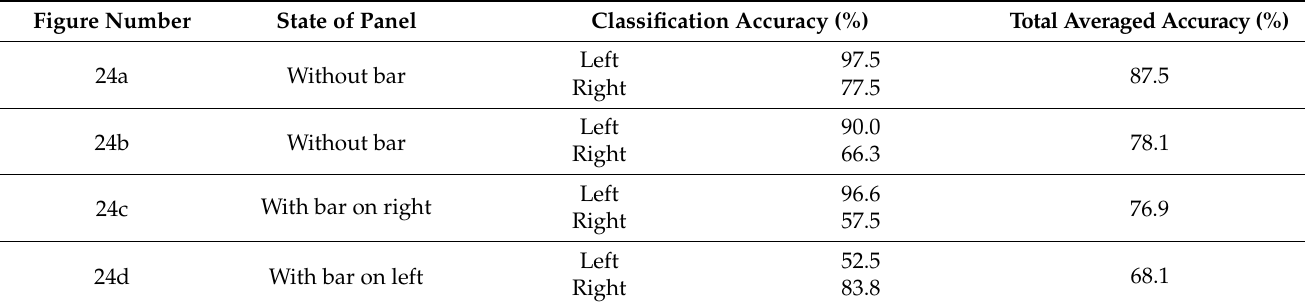
Table 13. Averaged classification